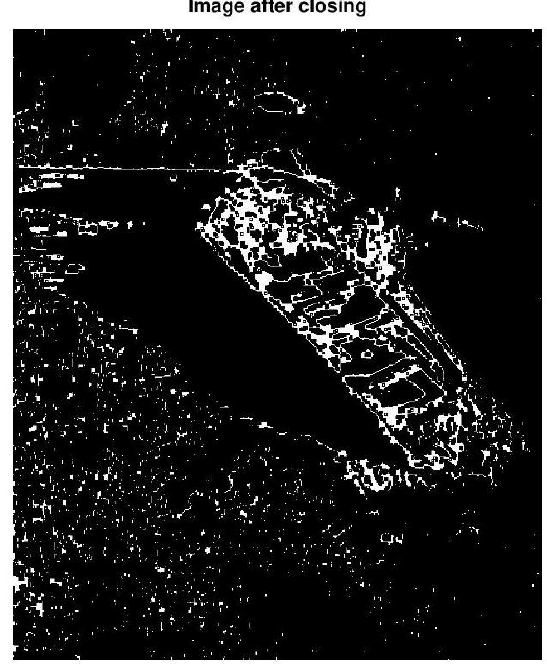
Figure 9. Corrosion expansion on Kirsch edge detection.